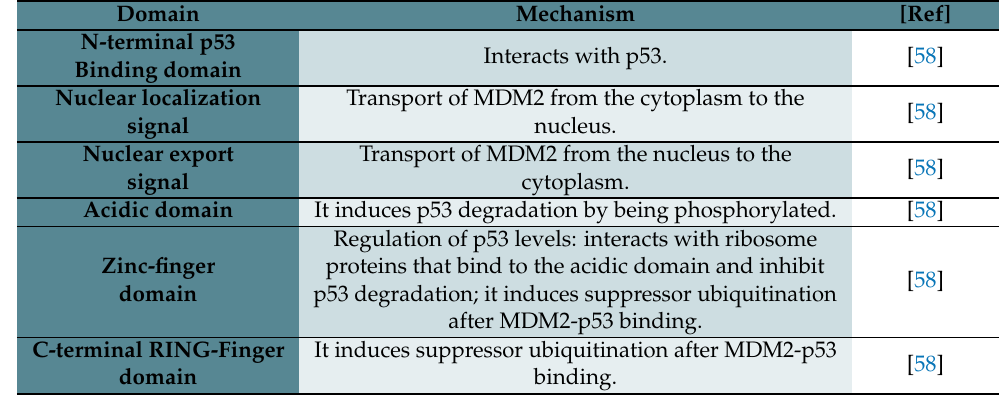
Table 2. The different domains of the MDM2